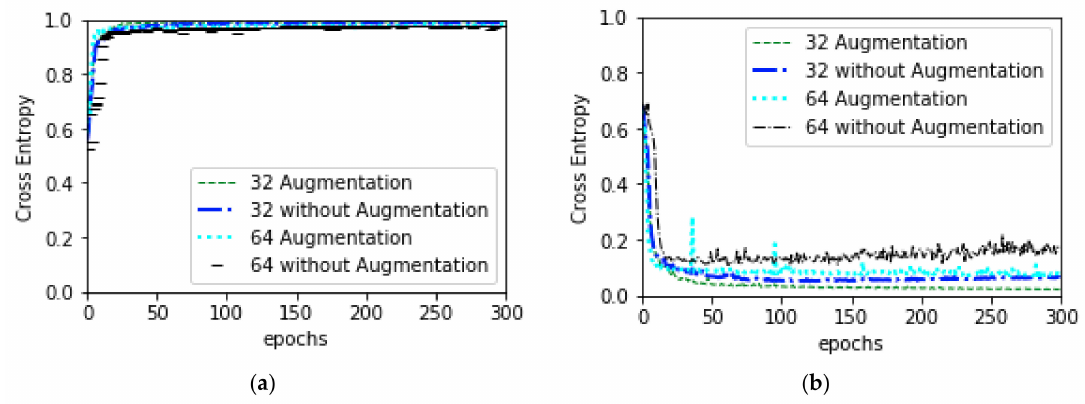
Figure 5. Combine validation accuracy and validation loss: ( a ) depicts combine validation accuracy and ( b ) depicts combine validation loss.